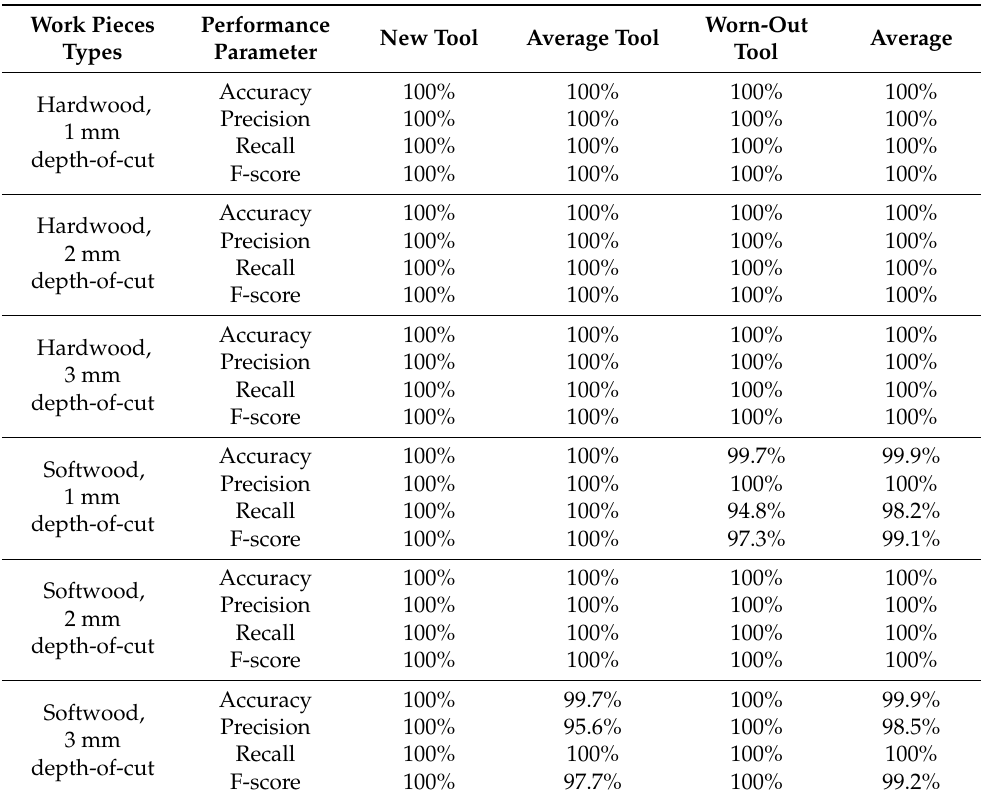
Table 4. Performance metrics for tool health